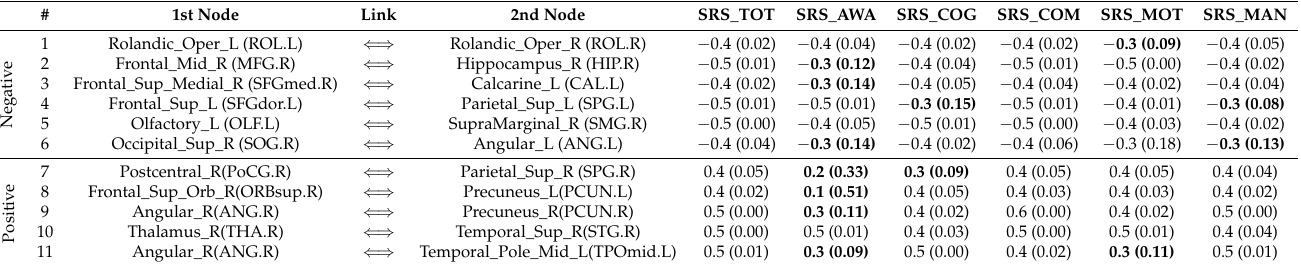
Table A2. Brain node connections with more than four significant positive or negative WCF correla- tions with SRS scores. The number in brackets is the p -value, which has a threshold at 95% confidence level, and the bold values are the p -values that exceed 0.05.